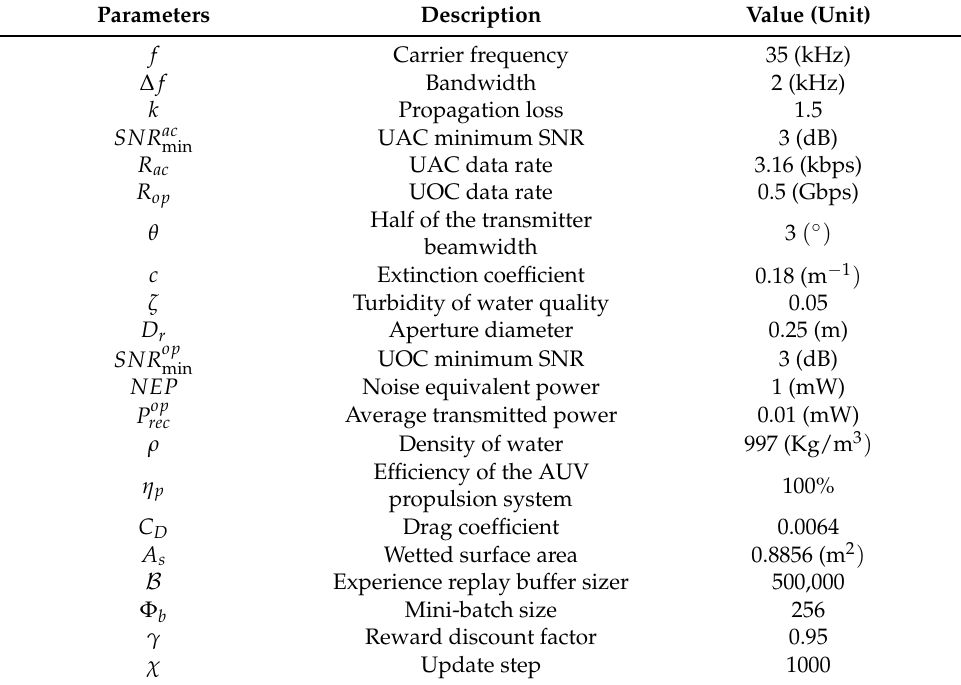
Table 1. Simulation